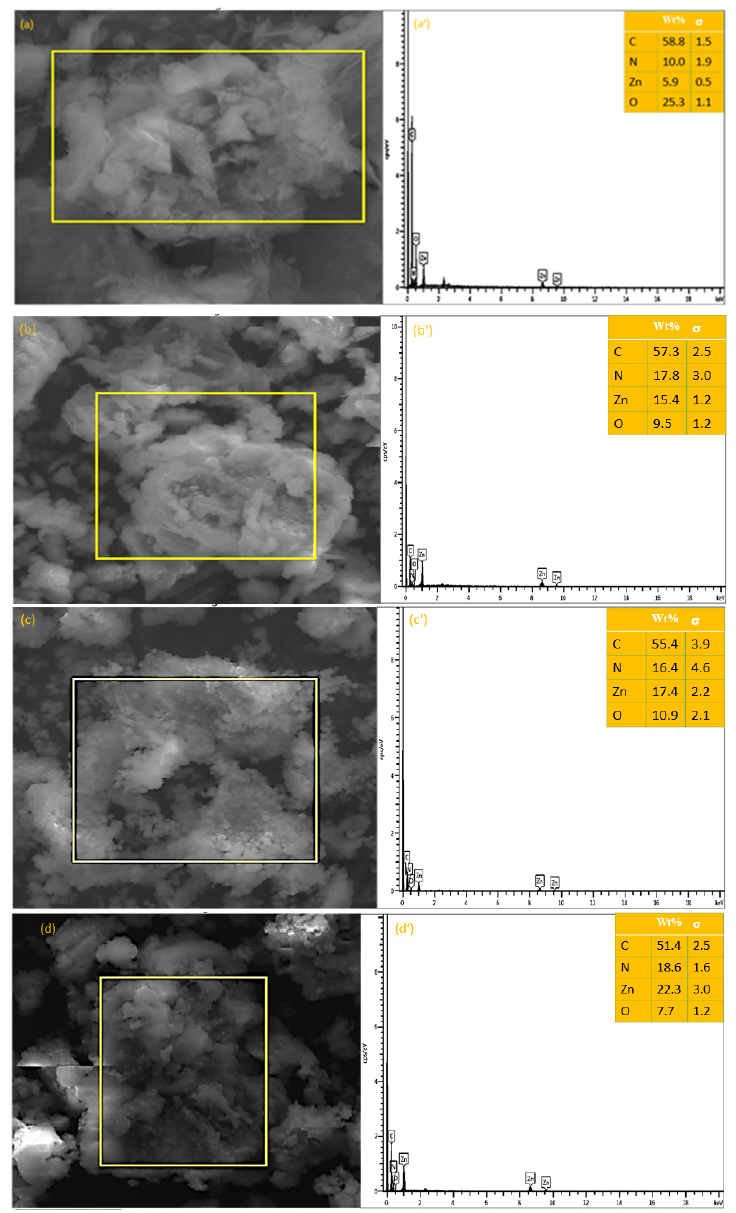
Figure 2. SEM images of ZIF-8@GO composites ( a–d ) and their respective EDS analysis ( a’–d’ ). Table 3 . Elemental composition obtained from SEM-EDS element analysis of synthesized composites. Sample